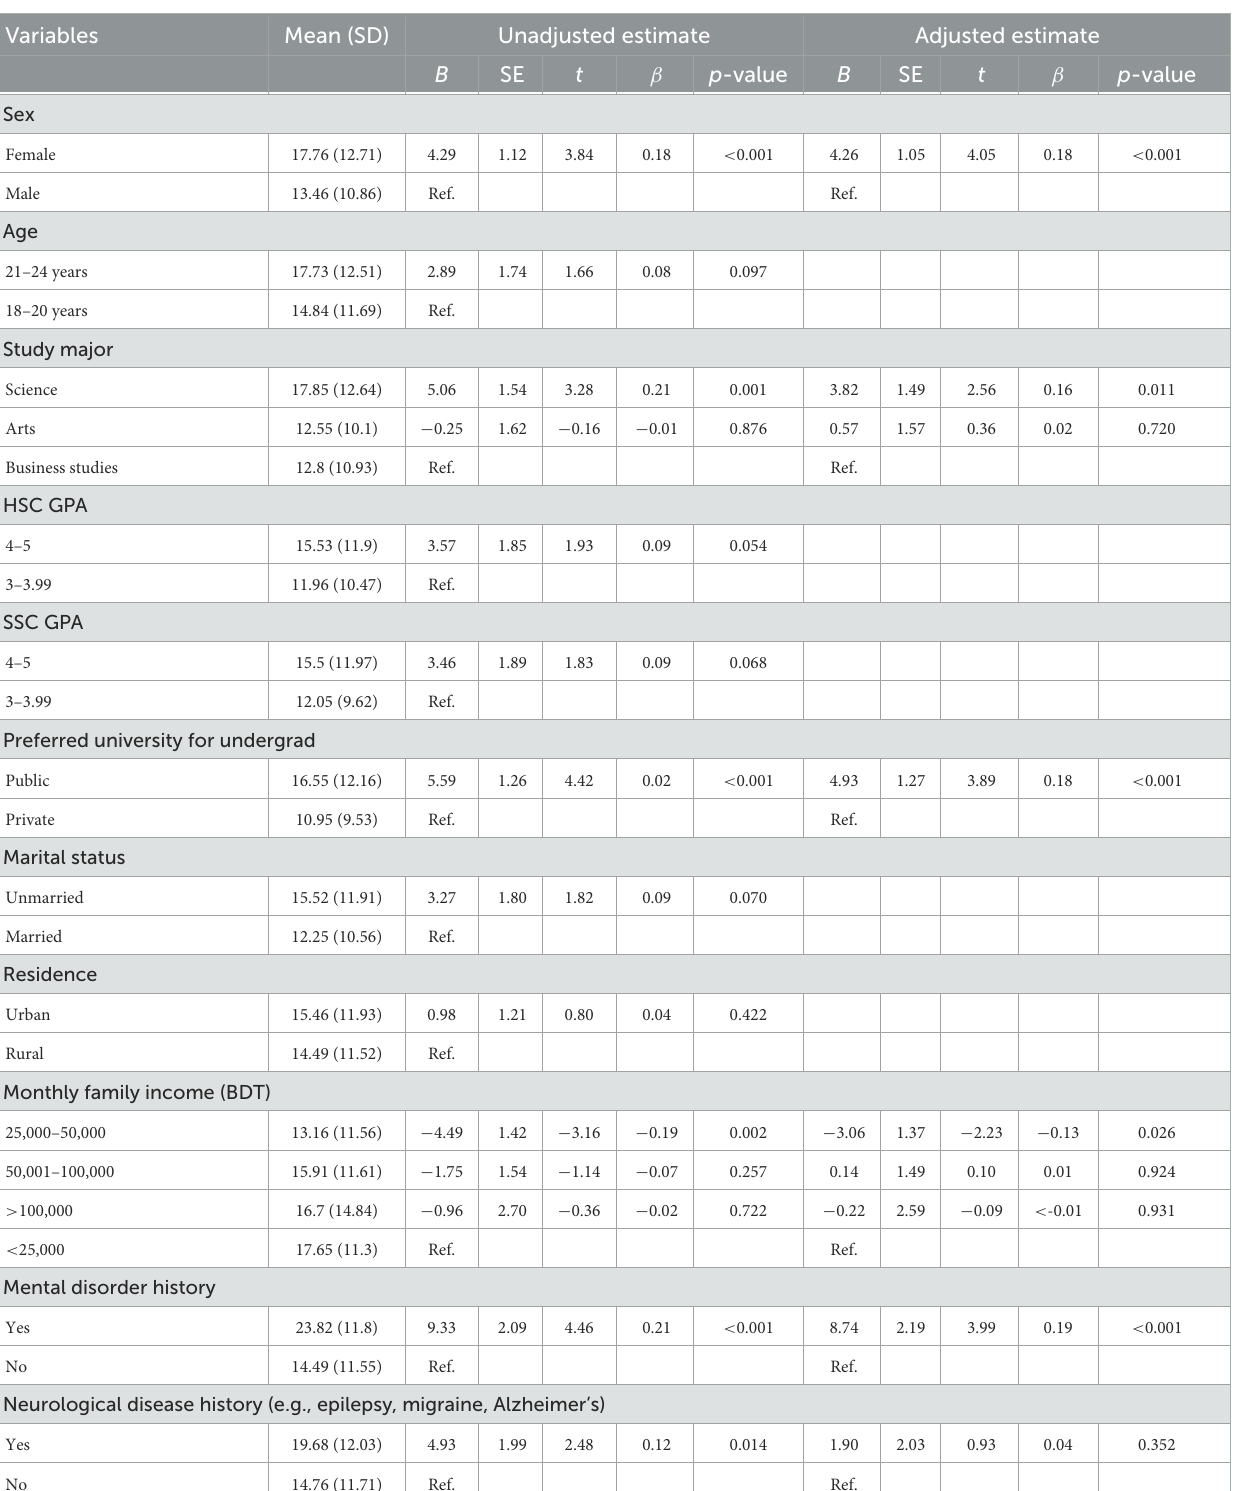
TABLE 2 Bivariate and multivariable regression analyses by depression